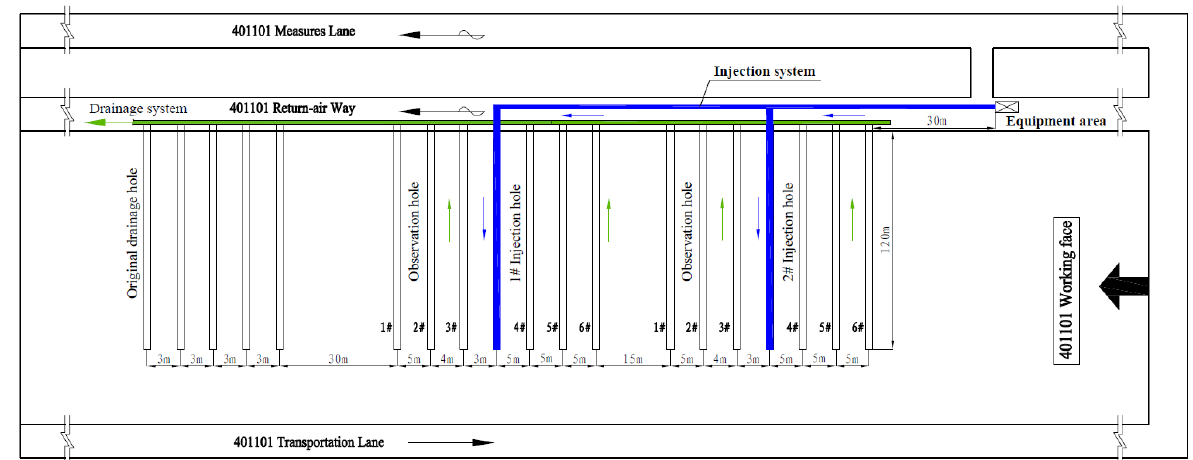
Table 3. Drilling design parameter table of L-CO 2 injection system.